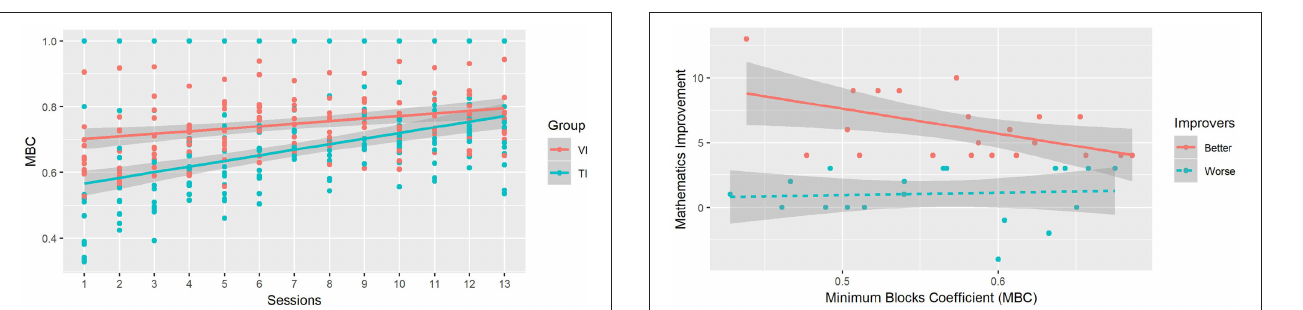
FIGURE 5 | Minimum Blocks Coefficient (MBC) for each session and experimental group. We applied a linear model to data points with a 95% confidence level.